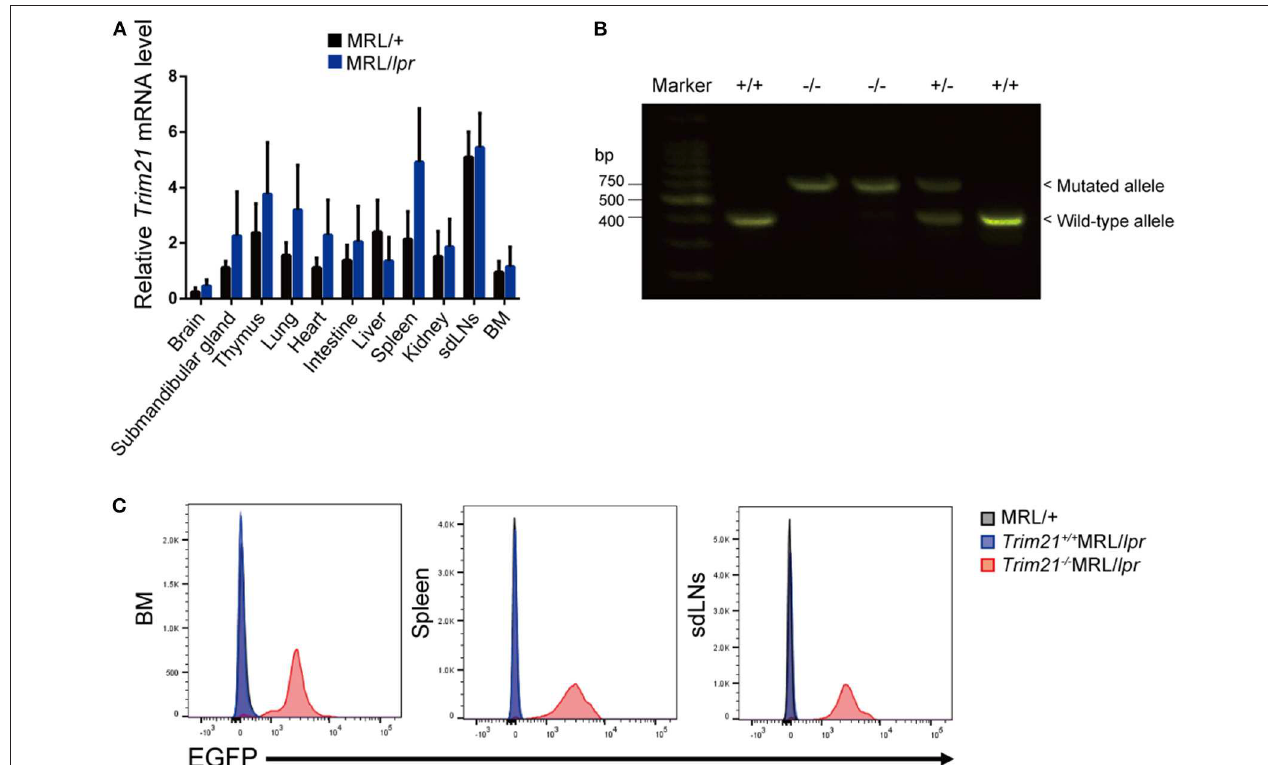
FIGURE 1 | Trim21 expression in tissues from MRL/ lpr mice and generation of Trim21 − / − MRL/ lpr mice. (A) Trim21 mRNA expression in tissues from MRL/ + and MRL/ lpr mice at 8 weeks of age. ( n = 4 in each group). (B) The genotype of Trim21 is determined by PCR of genomic DNA from the tail. Arrows indicate the position of bands to detect the wild-type and mutated alleles. (C) Flow cytometric analyses reveal the EGFP expression by the mutated alleles in cells from BM, spleen and sdLNs of the 8-week-old Trim21 − / − MRL/ lpr mice. Data are representatives of at least three independent experiments. Values are shown as means ± SEM.